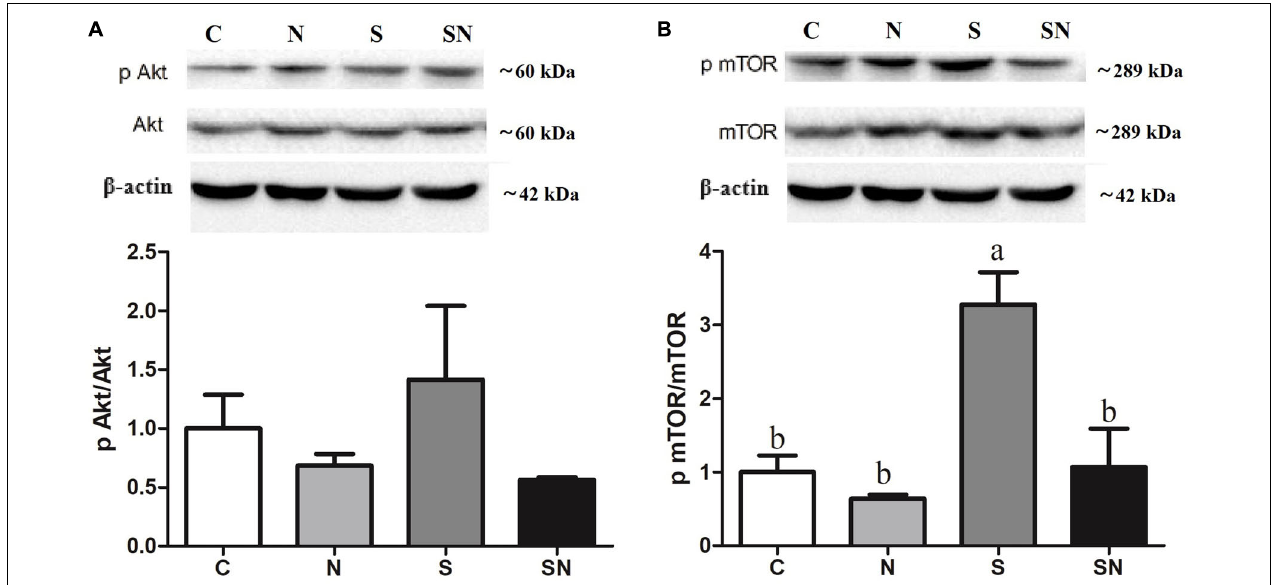
FIGURE 8 | Effect of Fe 3 O 4 -NPs on phosphorylated protein expression in PI3K/Akt/mTOR signaling in the livers of chickens exposed to Fe 3 O 4 -NPs in the absence or presence of S. Enteritidis administration. (A) Phosphorylated Akt/Akt expression, (B) phosphorylated mTOR/mTOR expression. Values represent the mean ± SEM. Different letters indicate statistically significant